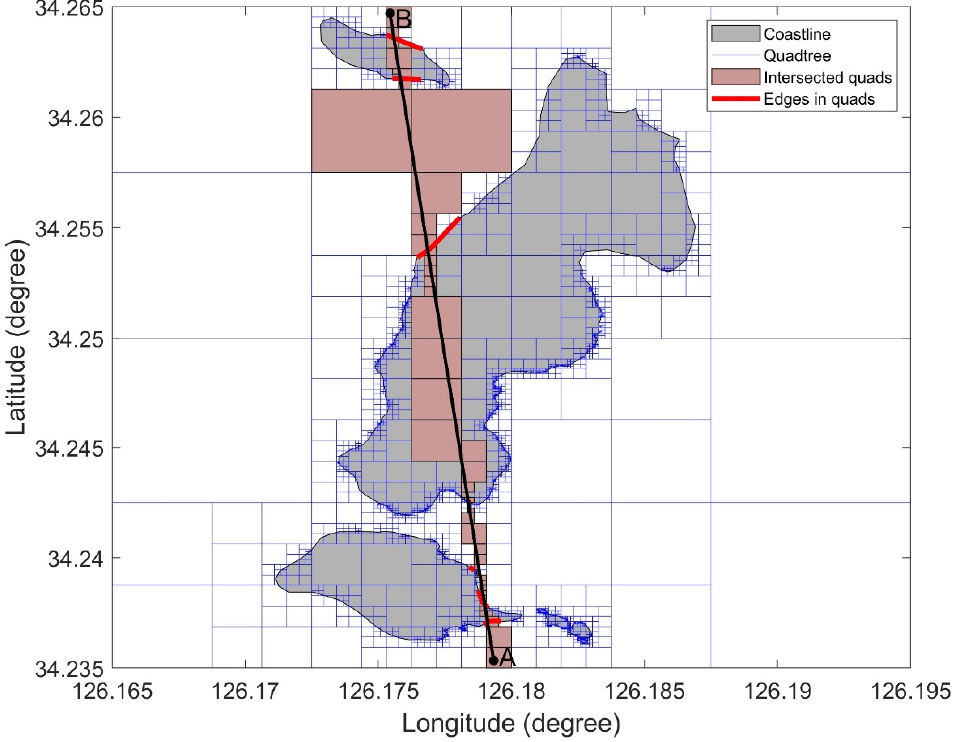
Figure 4. Example of edges in quads intersecting with line.